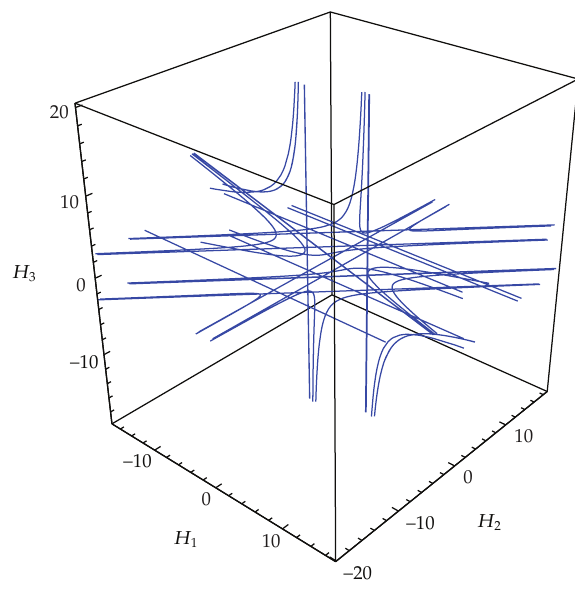
Figure 2: The evolution of the Hubble parameters for (cid:2) 3.5 (cid:3) .